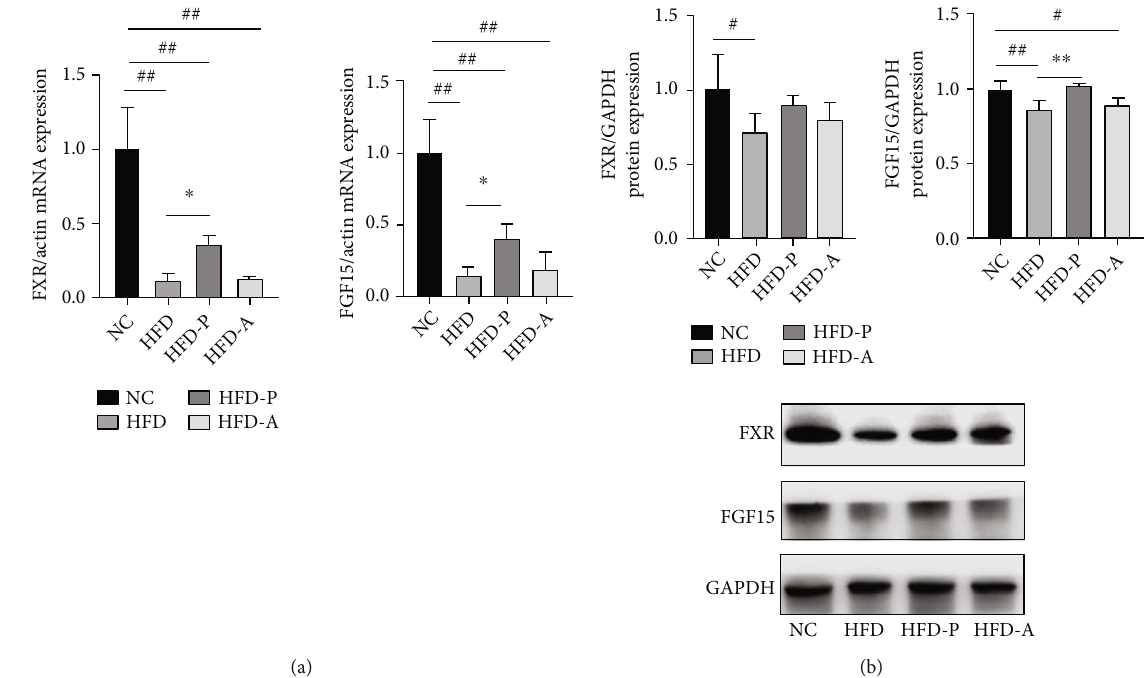
Figure 5: E ff ects of probiotics on the expression of FXR/FGF15 in the liver of NAFLD rats: (a) the expression of FXR and FGF15 in the liver of NAFLD rats; (b) Western blot for FXR and FGF15 in the liver of NAFLD rats. # P < 0 : 05 and ## P < 0 : 011 versus the NC group; ∗ P < 0 : 05 and ∗∗ P < 0 : 01 versus the HFD